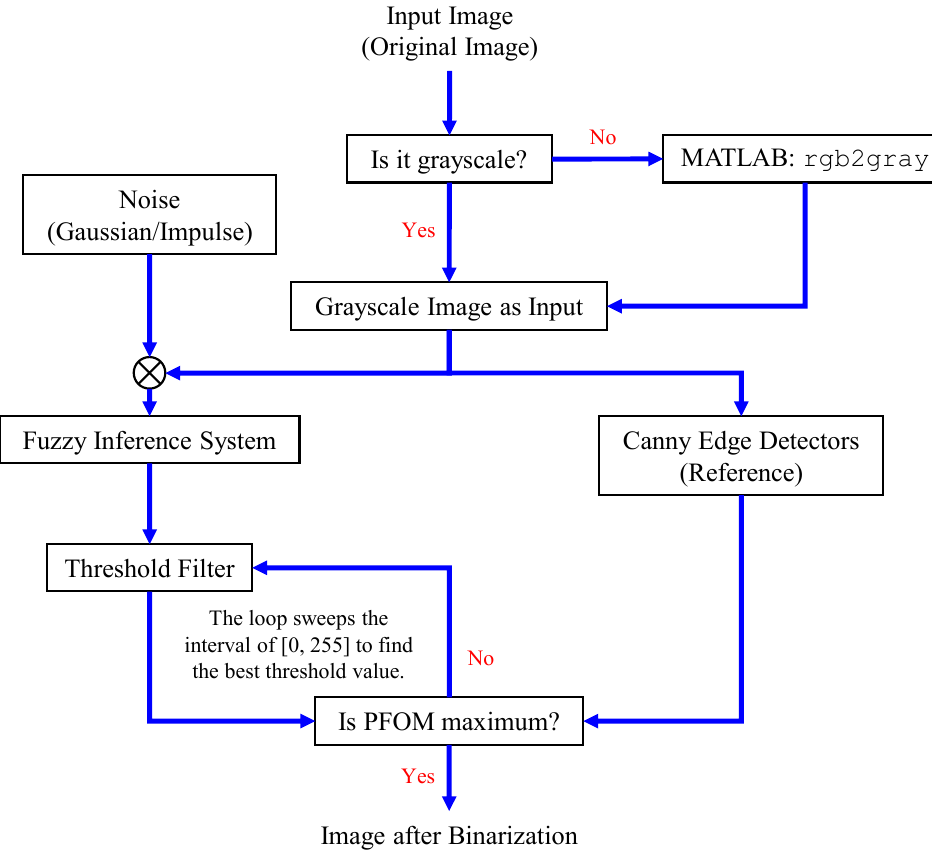
Figure 5. Flowchart of the employed procedure for fuzzy edge